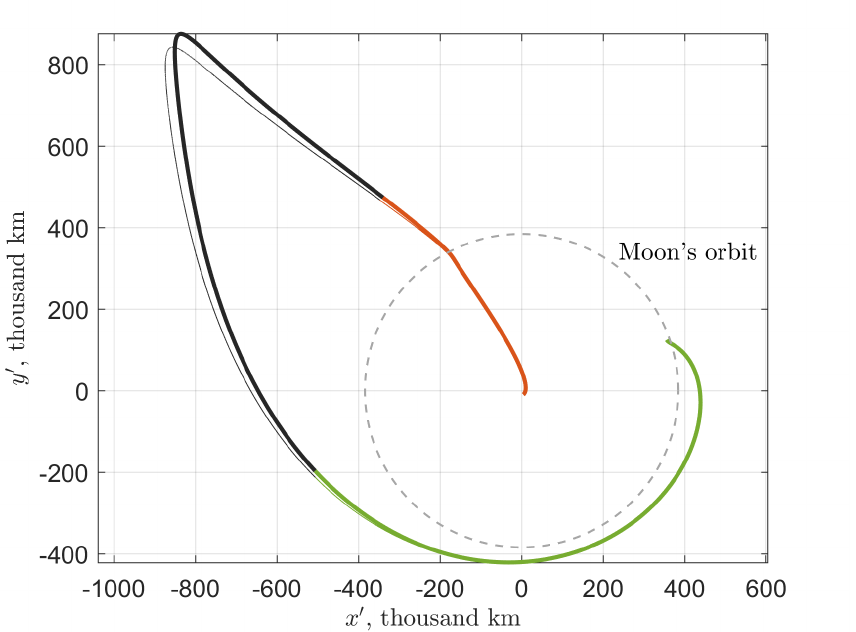
Figure 22. A sample SALT trajectory of the second type (with a direct lunar flyby): the patched three-body approximation (thin) and upon adaptation to the BR4BP (bold). As earlier, the adapted trajectory segments corresponding to the departing, arriving, and exterior legs, are colored the same (red, green, and black, respectively). Upon adaptation, the TLI burn has increased from 3163 m/s to 3166 m/s. The burn phase has changed from 221.84 deg to 221.43 deg. The apogee TCM of 0.6 m/s has been